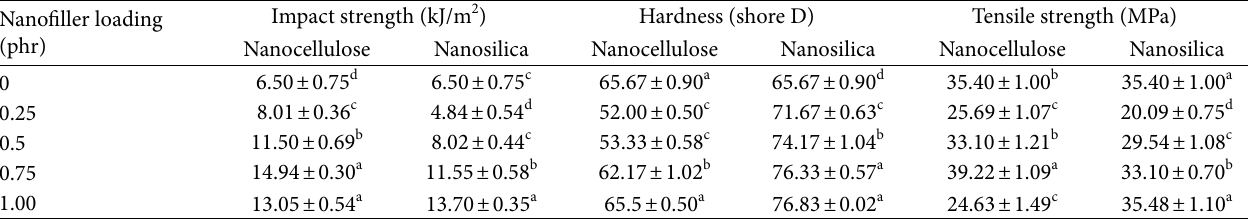
a, b, c, d Different superscripts indicate statistically significant differences at 95% confidence by Duncan’s method. Mean ± SD: mean and standard deviation based on triplicate